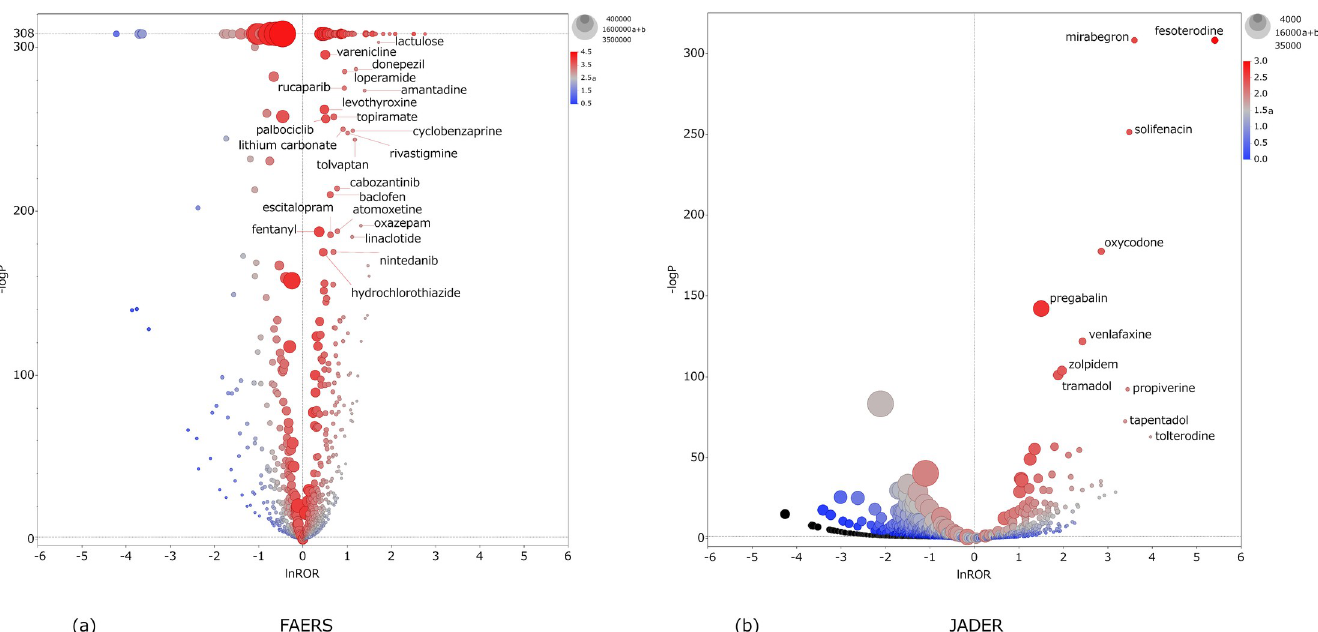
Fig 2. Scatterplot of ALL. Tendency of inducing all anticholinergic AEs (ALL) by each drug. (a) FAERS and (b) JADER.